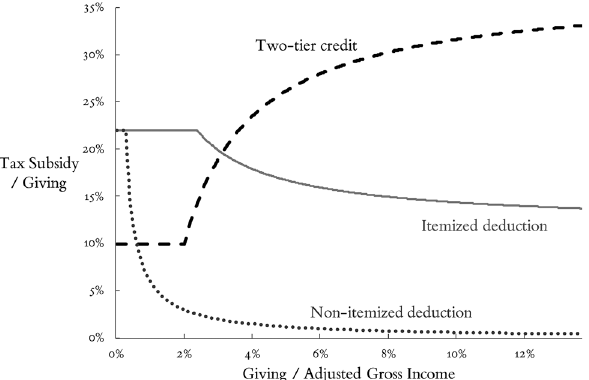
Figure 1: Ratio of tax subsidy to charitable contributions, as share of income given